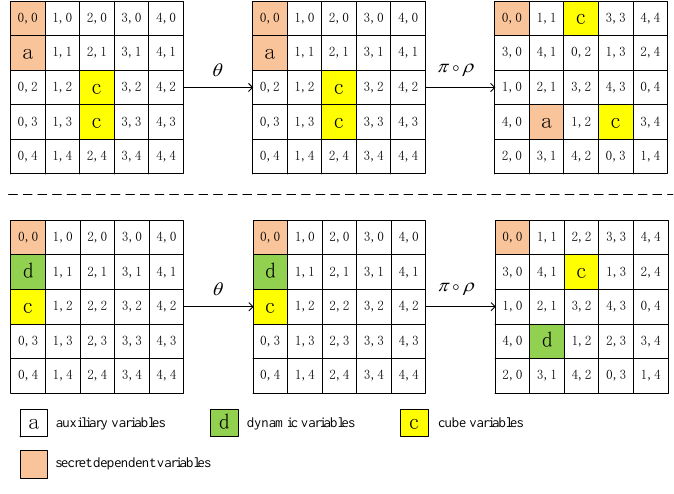
Figure 10: Comparing Dynamic Variables with Auxiliary